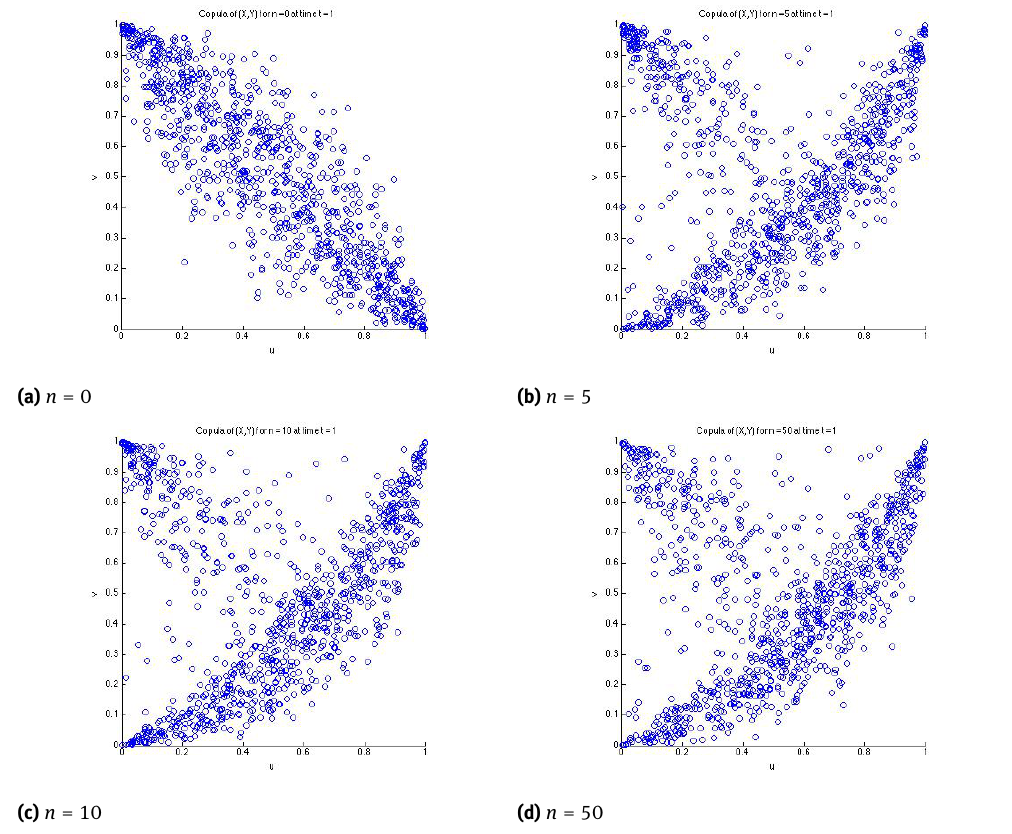
Figure 4: Empirical copula of ( X , Y n ) in the multi-barrier correlation model at time t = 1 with parameters ν = 0, η = 0.5 and ρ = 0.9 and a time step of 0.001 for different values of n done with 1000